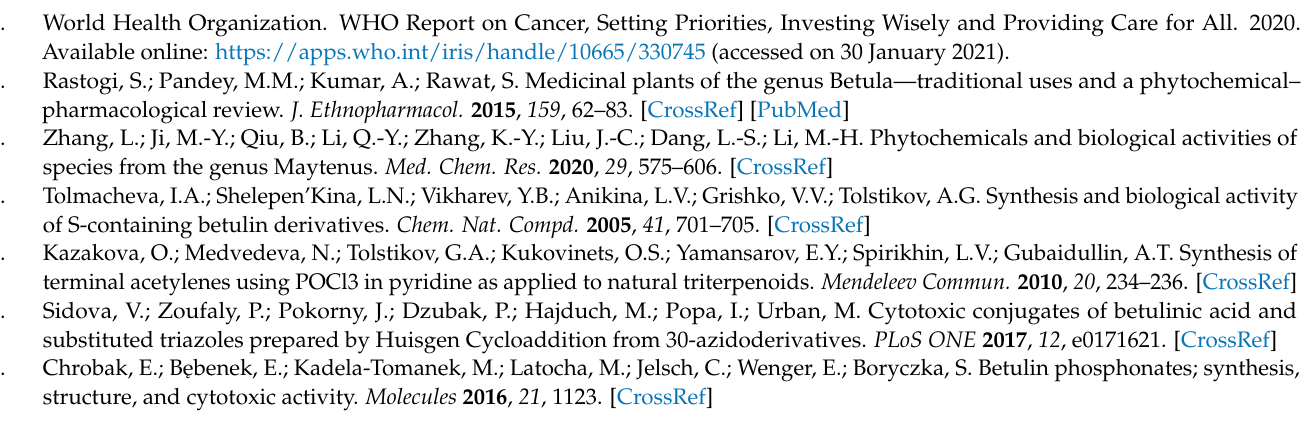
propynoyl)-30-diethoxyphosphoryloxybetulin 7c , Table S1. Calculated Raman band frequencies and assignments for compounds 5 and 10 , X-ray diffraction experiment, Table S2 Crystal parameters, data collection and refinement details for compound 5 , Table S3 Monocrystal characteristic, Table S4 Selected hydrogen bonds in the crystal structure of compound 5 , Chromatographic procedure by RP-TLC, Table S5. The theoretical values of lipophilicity for tested compounds 3 – 5 , 6a – 6e and 7a – 7e , Table S6. The correlation matrix for theoretically obtained lipophilicity parameters of compounds 3 – 5 , 6a – 6e and 7a – 7e